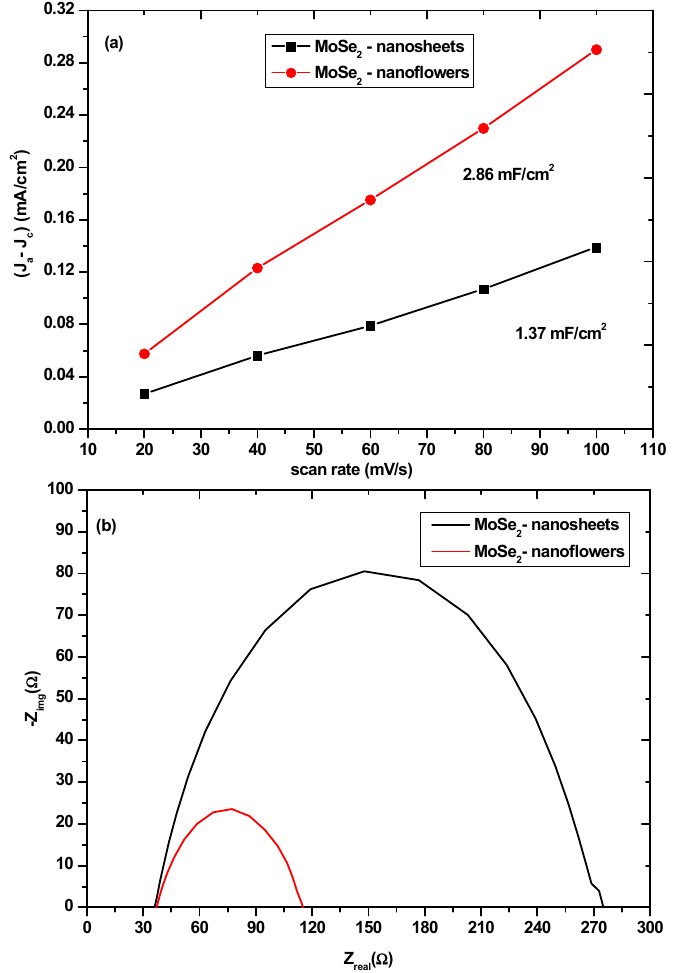
Figure 7. ( a ) linear fitting of the capacitive currents of MoSe 2 -nanosheets and MoSe 2 -nanoflowers vs the increasing scan rates. ( b ) Nyquist plots of the MoSe 2 -nanosheets and MoSe 2 -nanoflowers at − 200 mV vs RHE.